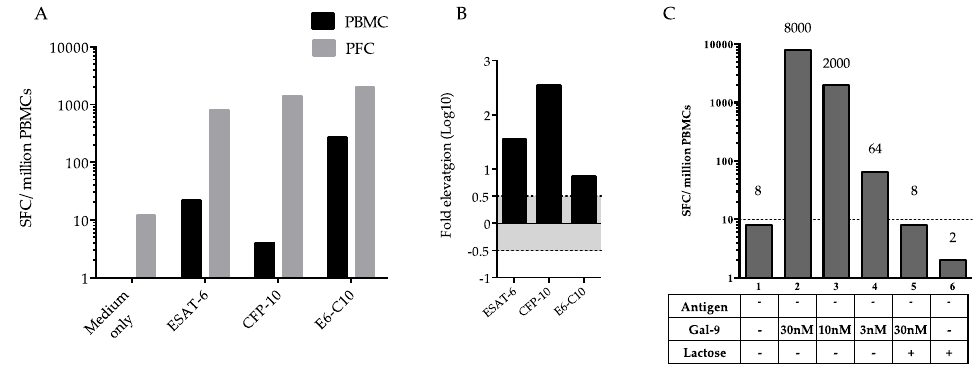
Figure 3. ELISPOT assay of IFN- γ production by PBMCs and PFCs. ( A ) SPCs among peripheral blood mononuclear cells (PBMCs) and pleural fluid cells (PFCs) stimulated with TB antigens; ( B ) Comparison of ELISPOT results between PBMCs and PFCs; black columns show a significant increase in log10 fold elevation of SPCs among PFCs compared to PBMCs; ( C ) Effect of exogenous Gal-9 and lactose in the absence of TB antigens on the number of IFN- γ -producing SPCs. E6-C10, combination of ESAT-6 and CPF-10.